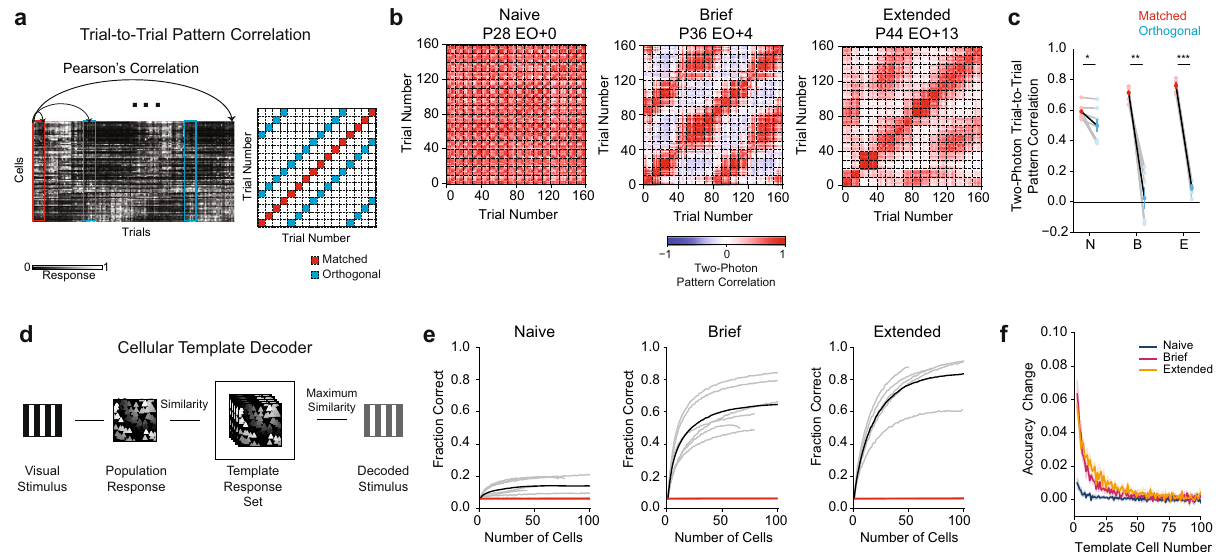
Fig. 2 Population responses of GABA-INs to orientation become more differentiable after visual experience. a Trial-to-trial pattern correlation matrices were generated by comparing population trial responses across stimulus conditions. Trials were sorted by direction, such that each group of 10 trials corresponds to the repeated presentation of a stimulus direction. Sixteen directions were presented equally spaced between 0 and 337.5 degrees. b Example trial-to-trial pattern correlation matrices for a Naive (left), Brief (middle), and Extended (right) experience animal. Dashed lines denote groups of the same stimulus direction. c Comparisons of trial-to-trial pattern correlation for matched (red) and orthogonal (blue) stimuli across age groups (Naive: N ( p = 0.0316, n = 7), Brief: B ( p = 0.0006, n = 6), Extended: E ( p < 0.0001, n = 5)). Two-tailed bootstrap test. d Schematic of the template decoding algorithm. e Decoding fraction versus number of cells used in the template decoder for Naive (left, n = 7), Brief (middle, n = 6), and Extended (right, n = 5) animals. Results for individual animals (gray), grouped average (black), and shuf fl e (red). f Change in decoding accuracy versus the cell number in the decoder for Naive (blue, n = 7), Brief (magenta, n = 6), and Extended experience (gold, n = 5). Shaded regions denote SEM. * p < 0.05; ** p < 0.005; *** p < 0.0005, two-tailed bootstrap test. Source data are provided as a Source Data fi orientation tuning (Fig. 3b, d; Naive 0.32 ± 0.12 vs. Brief 0.88 ± 0.02, p = 0.0076, n = 5 vs. 4; Naive 0.32 ± 0.12 vs. Extended 0.94 ± 0.03, p = 0.0050, n = 5 vs. 5; Mean ± SEM, bootstrap test).